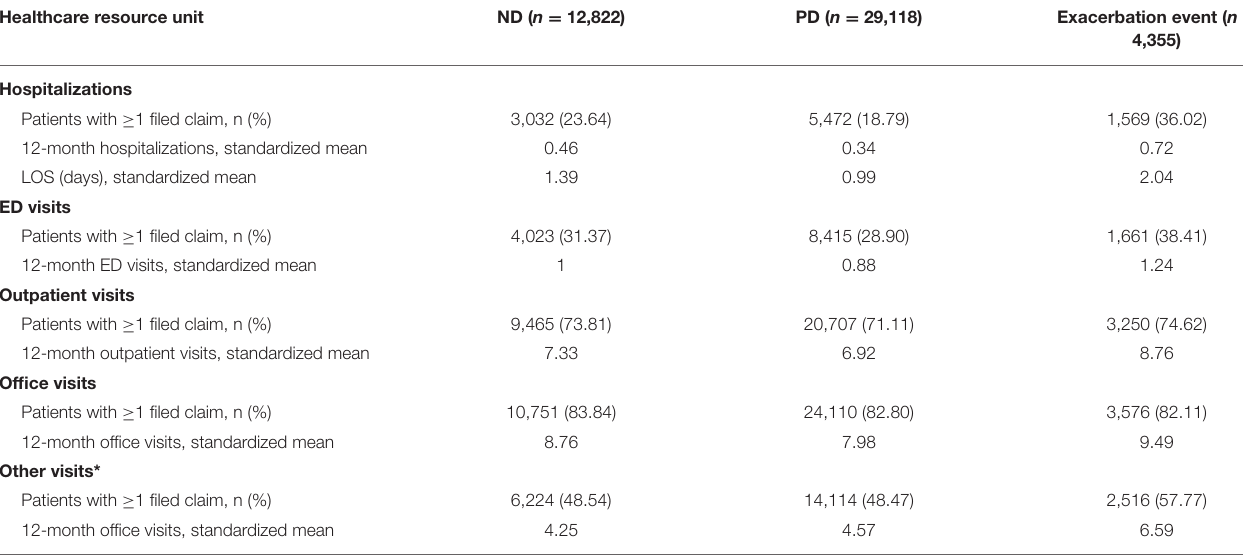
TABLE 2 | Standardized healthcare resource utilization in ND, PD, and exacerbation event subgroups over 12 months. Healthcare resource